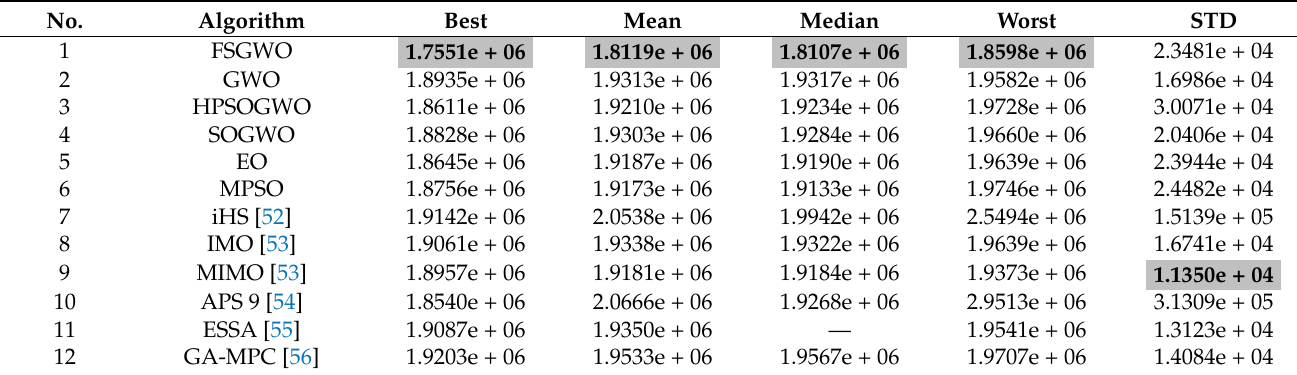
Table 13. Results of the related algorithms for the 140-unit ELD case.